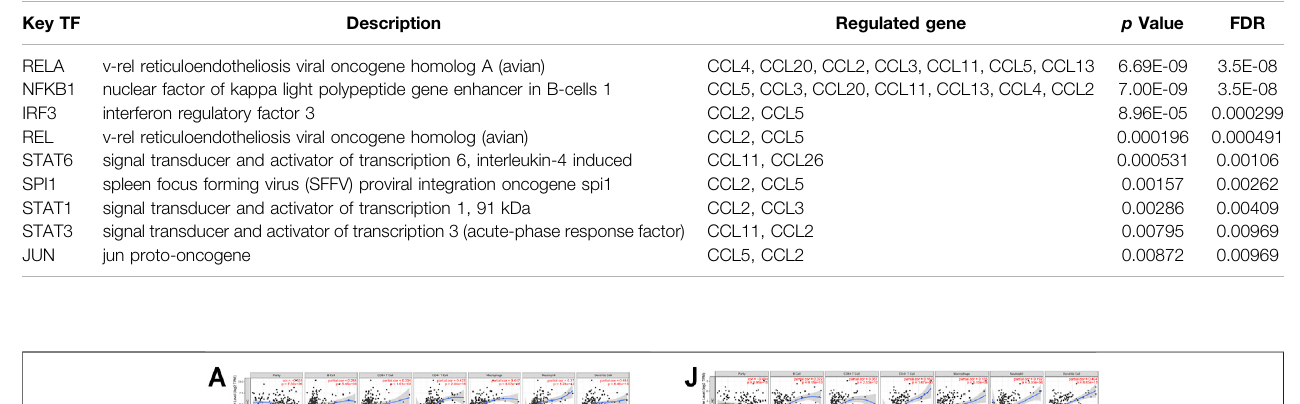
TABLE 3 | Key regulated factor of chemokines CCL in LIHC (TRRUST).